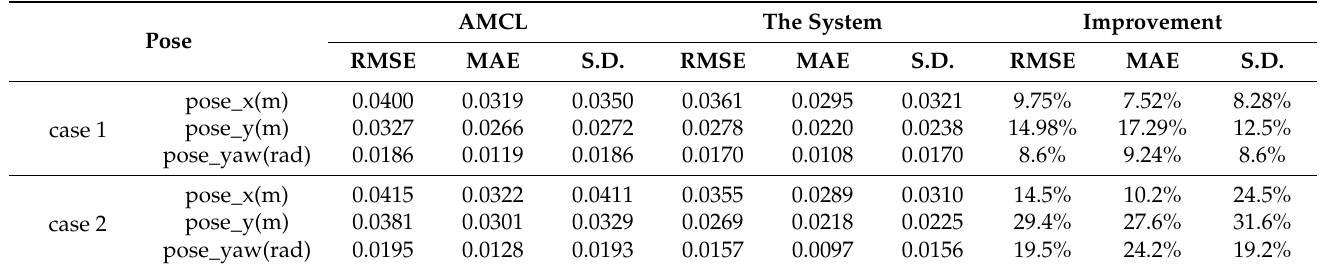
Table 2. The results of the pose estimation errors in case 1 and case 2, respectively.